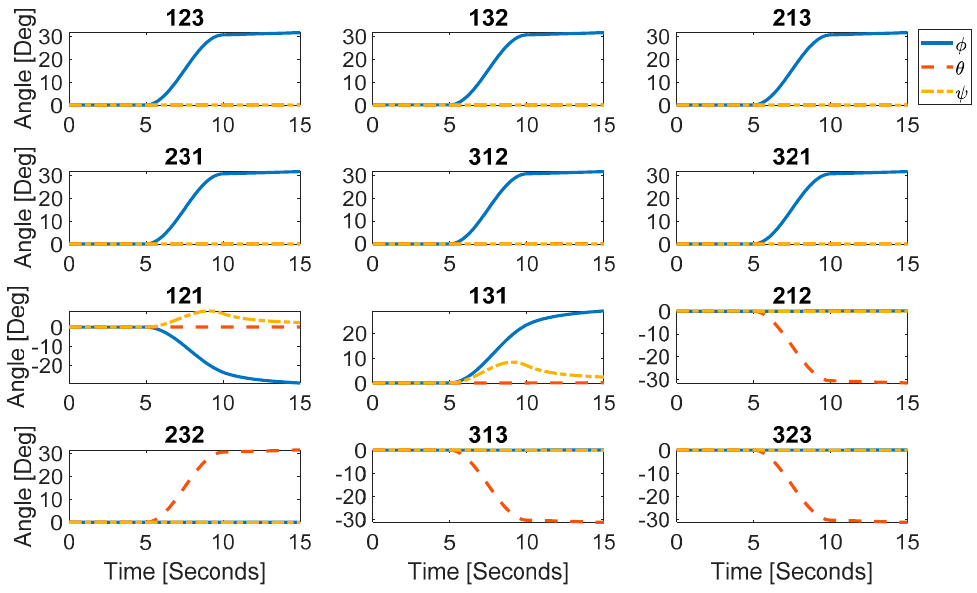
Figure 3. Corrected Euler Angles vs time for all 12 DCM rotations.